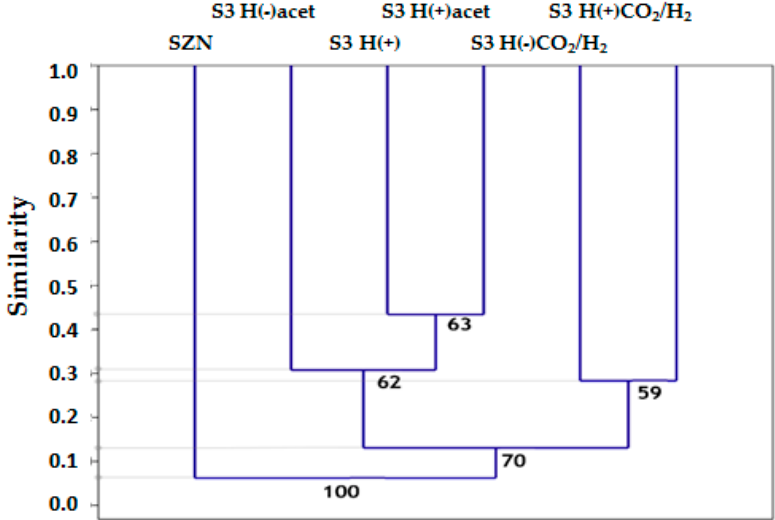
Figure 5. Beta-diversity of the bacterial communities in the experimental treatments. The similarity presented on the scale was calculated based on the Bray-Curtis distances, and the tree was generated by an UPGMA algorithm. The bootstrap number was set to 999.